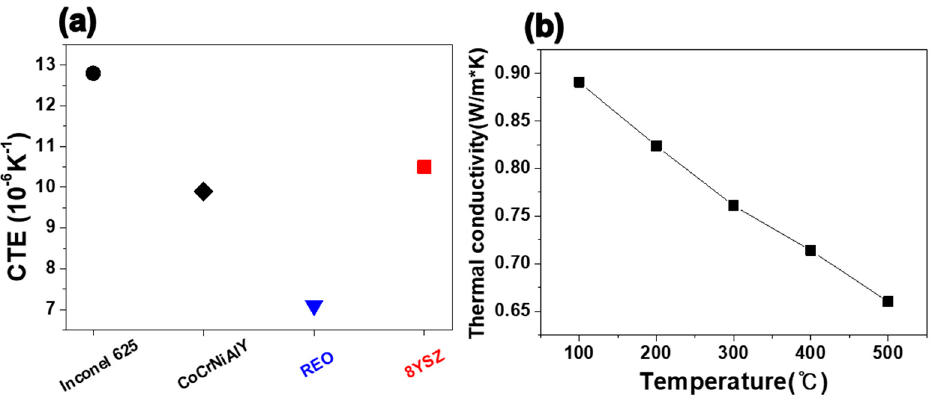
Figure 7. ( a ) CTEs of REO and other comparative materials; ( b ) thermal conductivities of REO and 8YSZ [71,72] with respect to temperature.